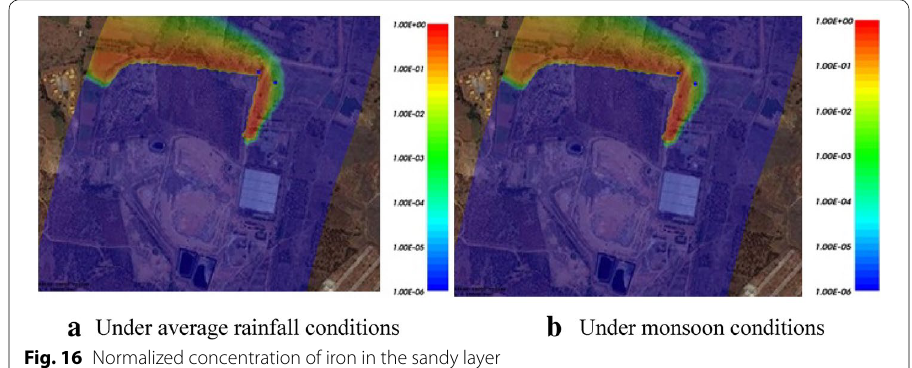
Fig. 16 Normalized concentration of iron in the sandy layer